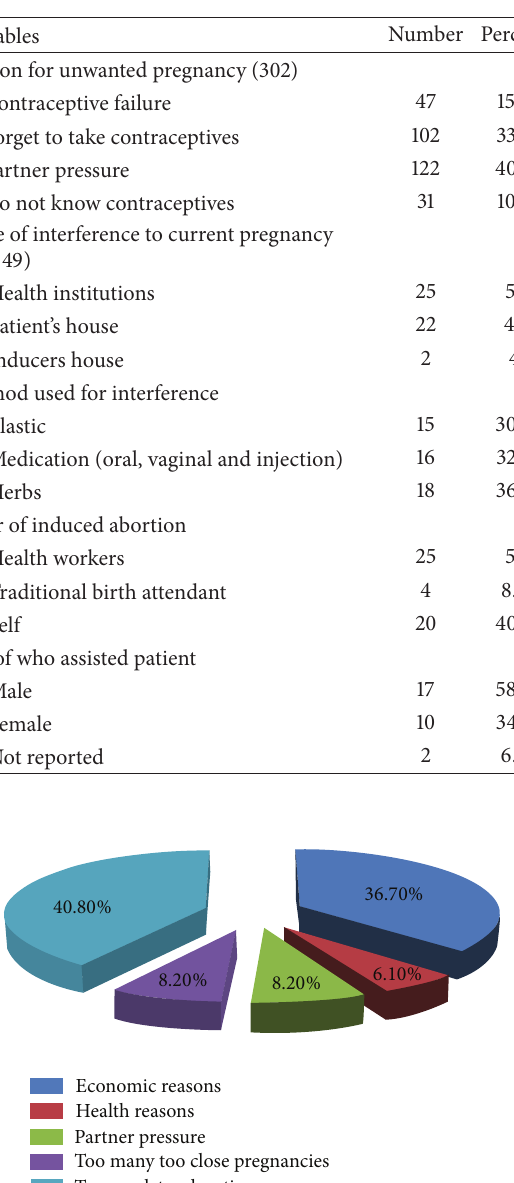
Table 3: Reasons for unwanted pregnancy, place and methods of interference to the current pregnancy among post abortion clients in health institutions of Guraghe zone, South Ethiopia, from January to March, 2010.